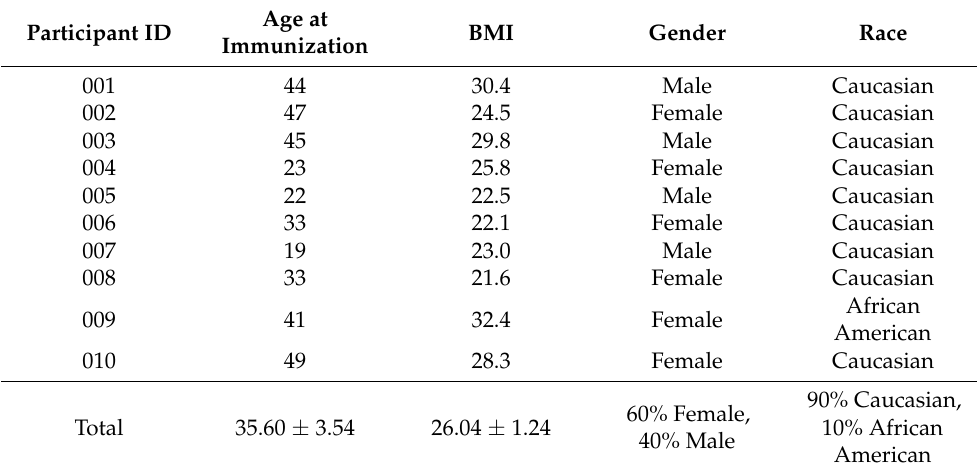
Table 1. Demography of the cohort analyzed in this